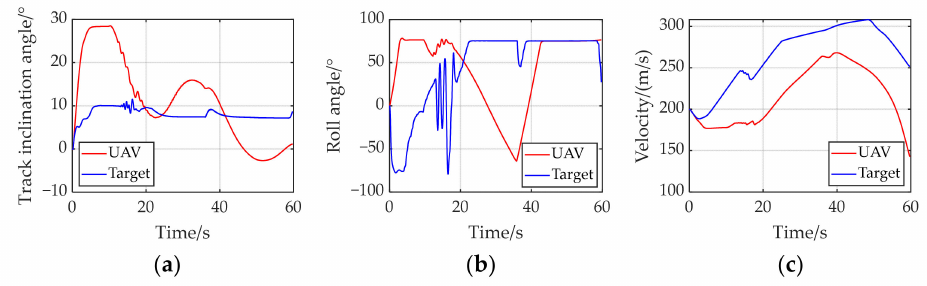
Figure 9. Flight status of the UAV in case 1: ( a ) track inclination angle, ( b ) roll angle, ( c ) speed. The air combat three-dimensional trajectory and plane trajectory of the two aircraft in case 2 are shown in Figures 10 and 11.